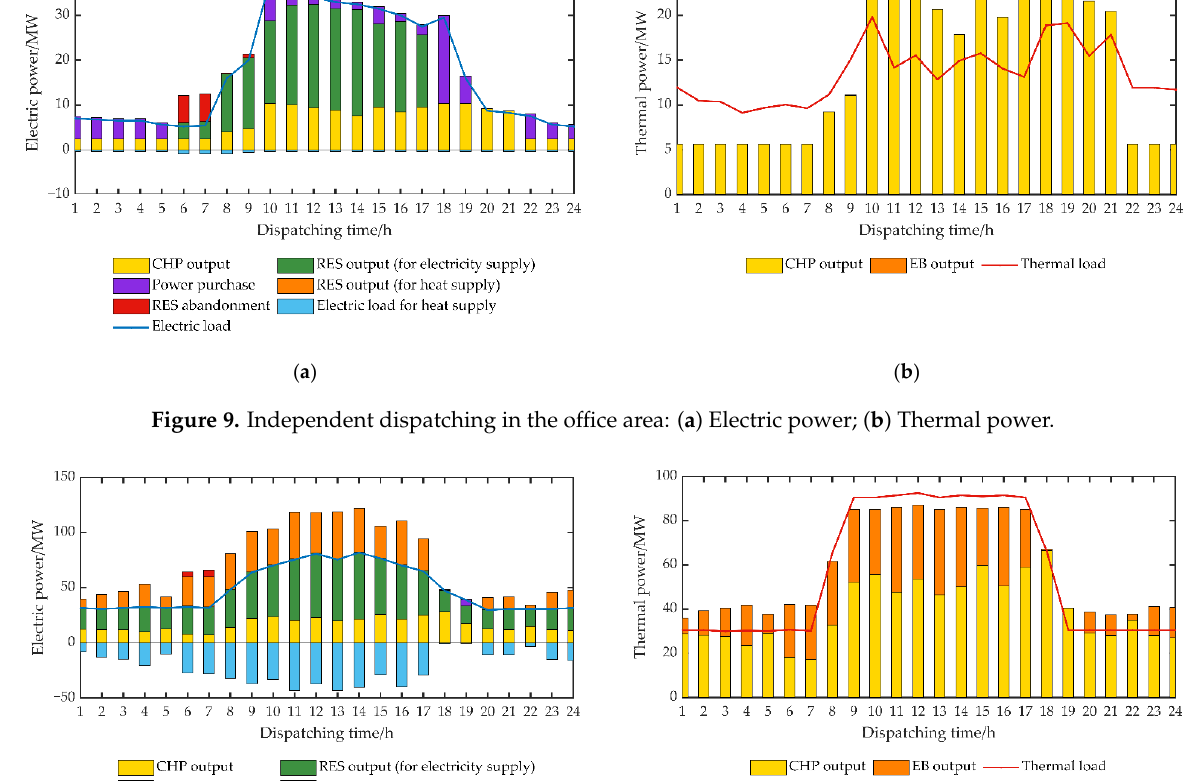
Figure 9. Independent dispatching in the office area: ( a ) Electric power; ( b ) Thermal power.